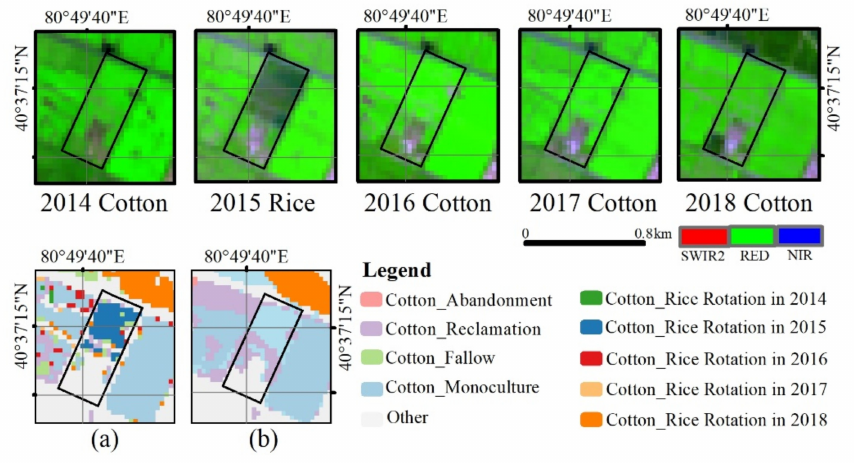
Figure 11. Cotton cultivation patterns at the Aksu Station; all remote sensing images are in July of each year; ( a ) multi-year cotton cropping pattern using RF method, ( b ) GIS-driven multi-year cotton cropping